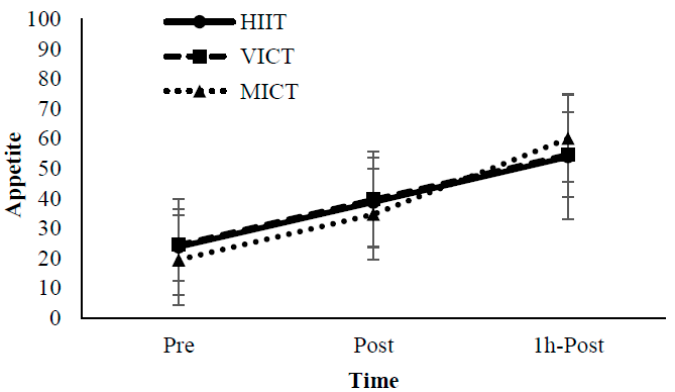
Figure 2. Appetite Scores. Pre: Immediately pre-exercise; Post: Immediately post-exercise; 1h-Post: 1-h post-exercise.